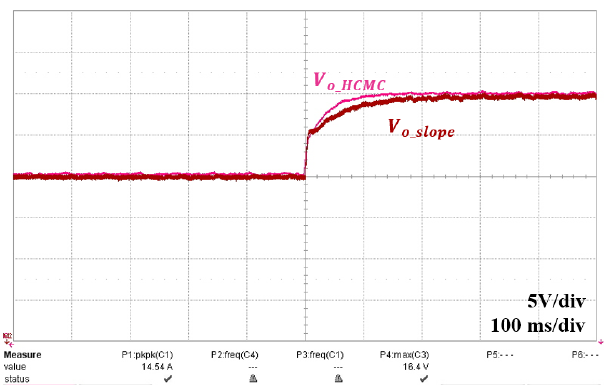
Figure 22. Experimental results of the voltage response of the proposed HCMC and conventional PCMC techniques (5 V/div, 100